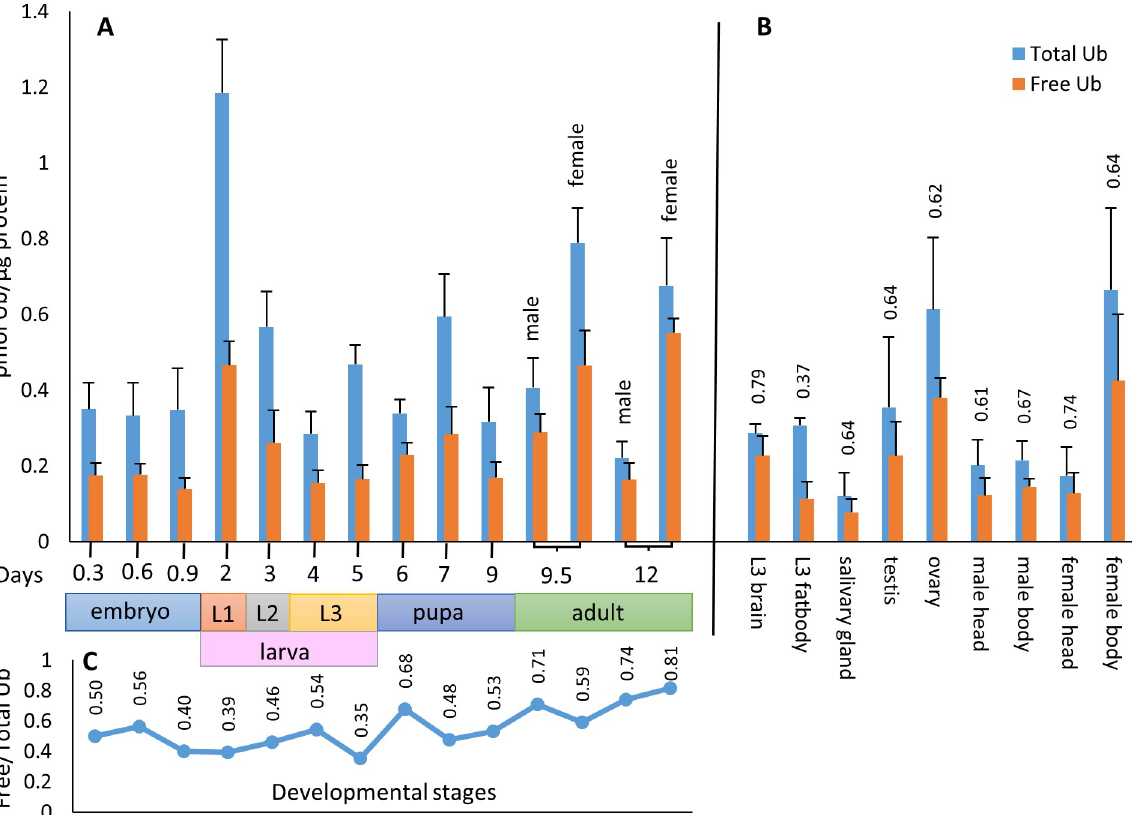
Fig 2. Developmental (A) and tissue specific (B) profile of free (light blue) and total (dark blue) ubiquitins and free/total ubiquitin ratios (C and above columns in B). The colour bar at the bottom indicates the length of the developmental stages at 25˚C. For panel B, tissues were prepared from third instar larvae (L3) and three day old adults. Ubiquitin content was normalized to total protein content. Data are presented as mean ± SD (see also S1 Table) of three independent experiments (n = 3). The data were compared using one-way analysis of variance (ANOVA) followed by SNK post-hoc test (see S2